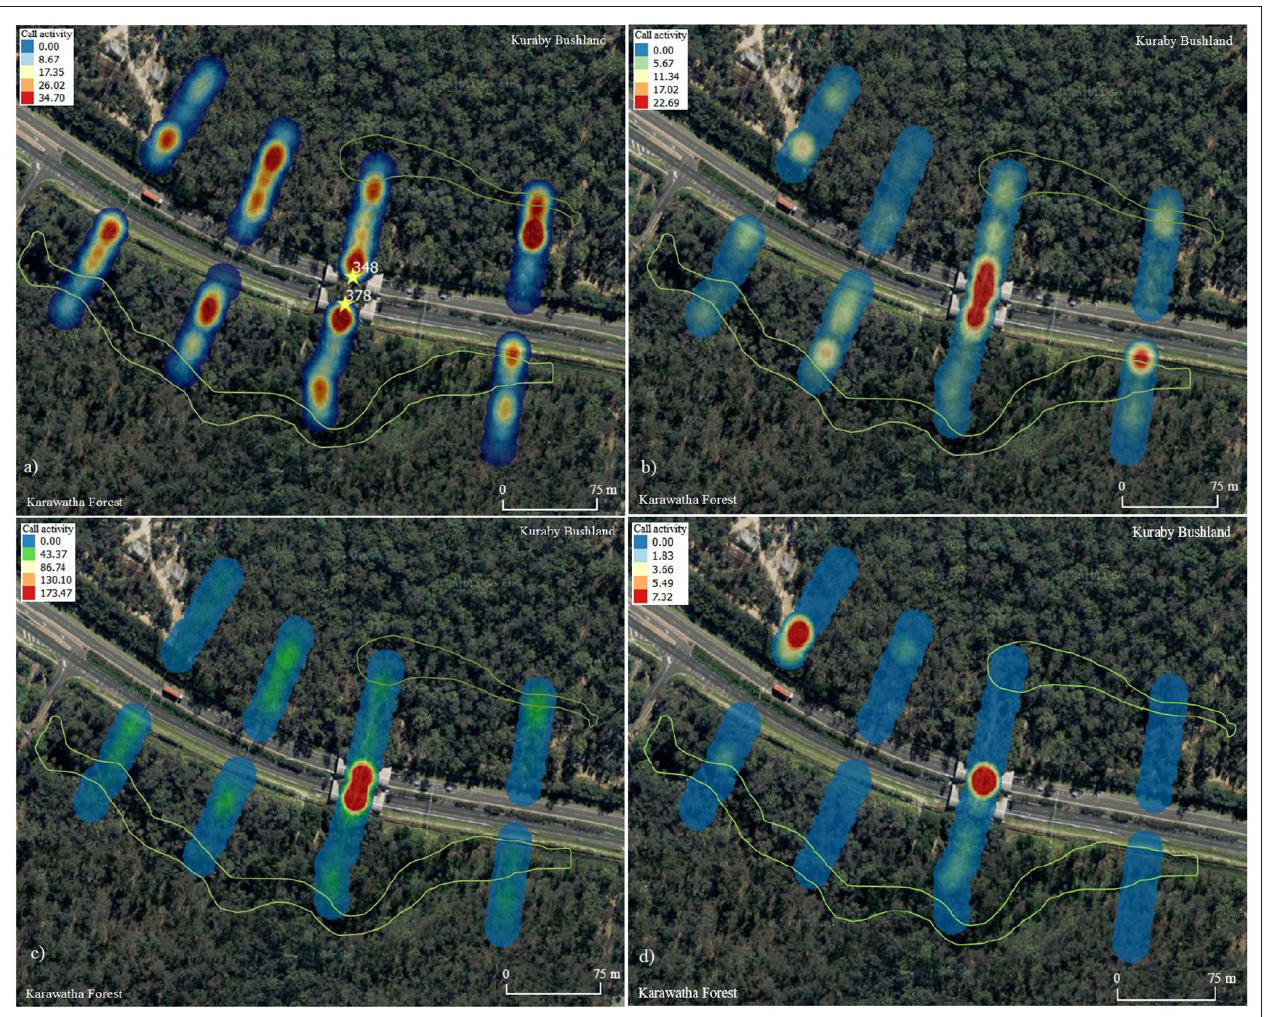
FIGURE 6 | Call activity along the transects for (a) all species, (b) open foraging species only, (c) edge foraging species, only and (d) gleaning species only (mean total calls). Call activity increases from blue to red with intensity (creek and marshland areas outlined in green). *Overpass calls for total species activity are noted